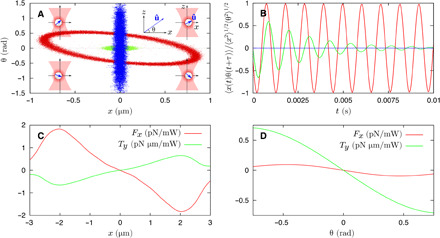
Simulations describing the correlation between the x and θ coordinates and their coupling forces and torques.(A and B) The correlation between x and θ for three separate cases: a birefringent sphere (Δn = 0.1) at low air viscosity (μ = 1 × 10−6 Pa s) (red), the same birefringent sphere at a higher viscosity (μ = 3.25 × 10−6 Pa s) (green), and an isotropic sphere (Δn = 0) at low viscosity (μ = 1 × 10−6 Pa s) (blue). (A) Scatter plot of the simulated coordinates. The insets at each corner show a complete cycle of successive rotations about the y axis and translations along the x axis (i.e., the electric polarization direction). (B) Cross-correlations, 〈x(t)θ(t + τ)〉, evaluated from the simulation data. (C and D) Calculations of the coupled forces Fx and torques Ty for x displacements (with θ = 0) and θ rotations (with x = 0), respectively.